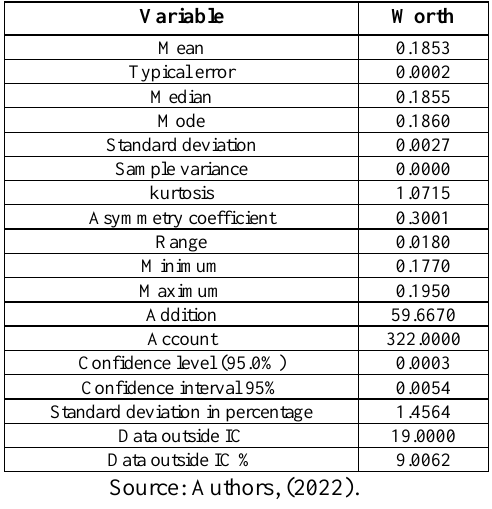
Table 2: Final statistical analysis (Phase 2).